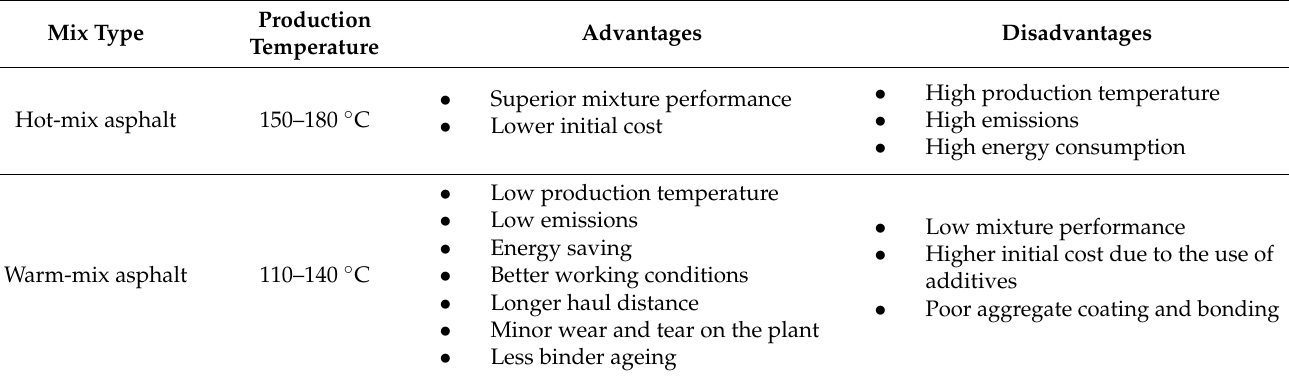
Table 2. The advantages and disadvantages of asphalt